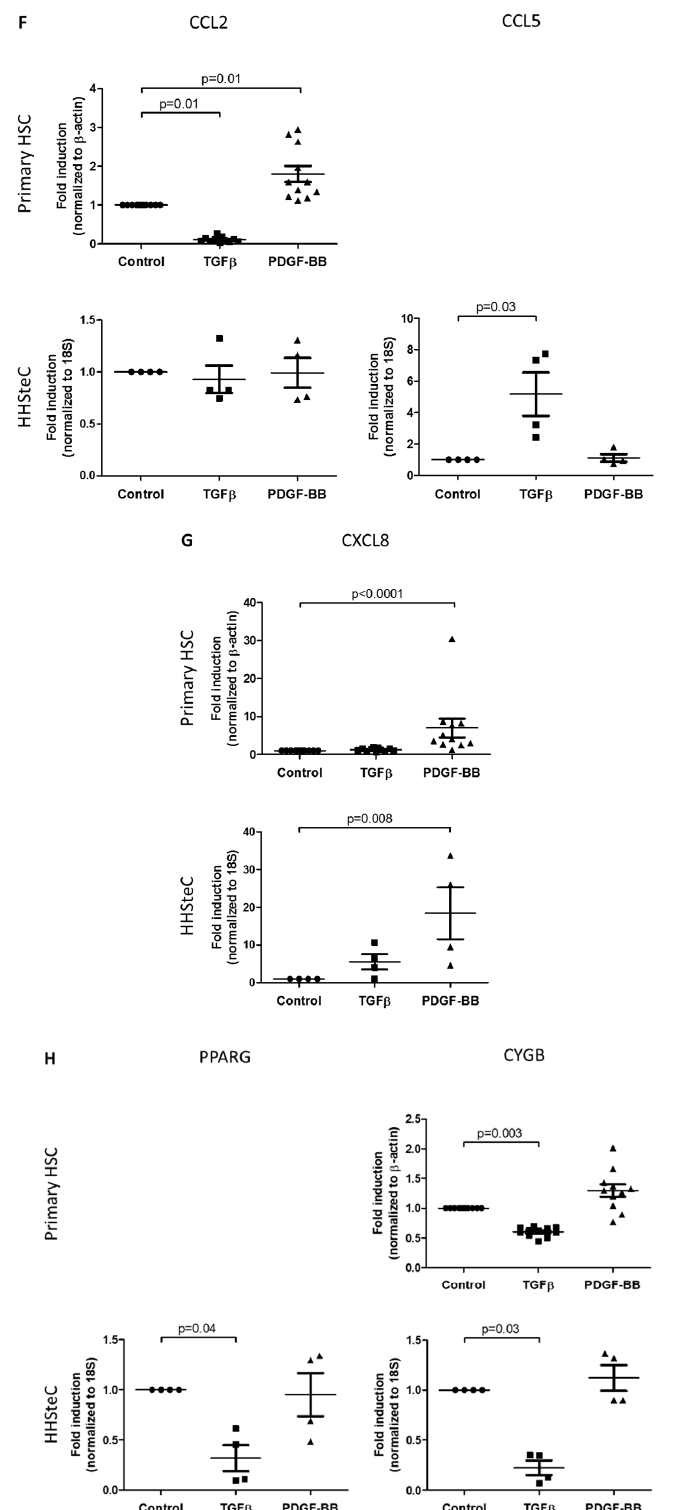
Figure 2. In vitro e ff ects of TGF β or PDGF-BB on the gene expression of markers for HSC-activities during fibrosis in primary HSCs ( n = 11, 3 di ff erent donors) and HHSteCs ( n = 4). HSC-activities and their associated genes include ( A ) activation ( ACTA2, PDGFRB, CCN2 ), ( B ) fibrogenesis ( COL1A1, FN1